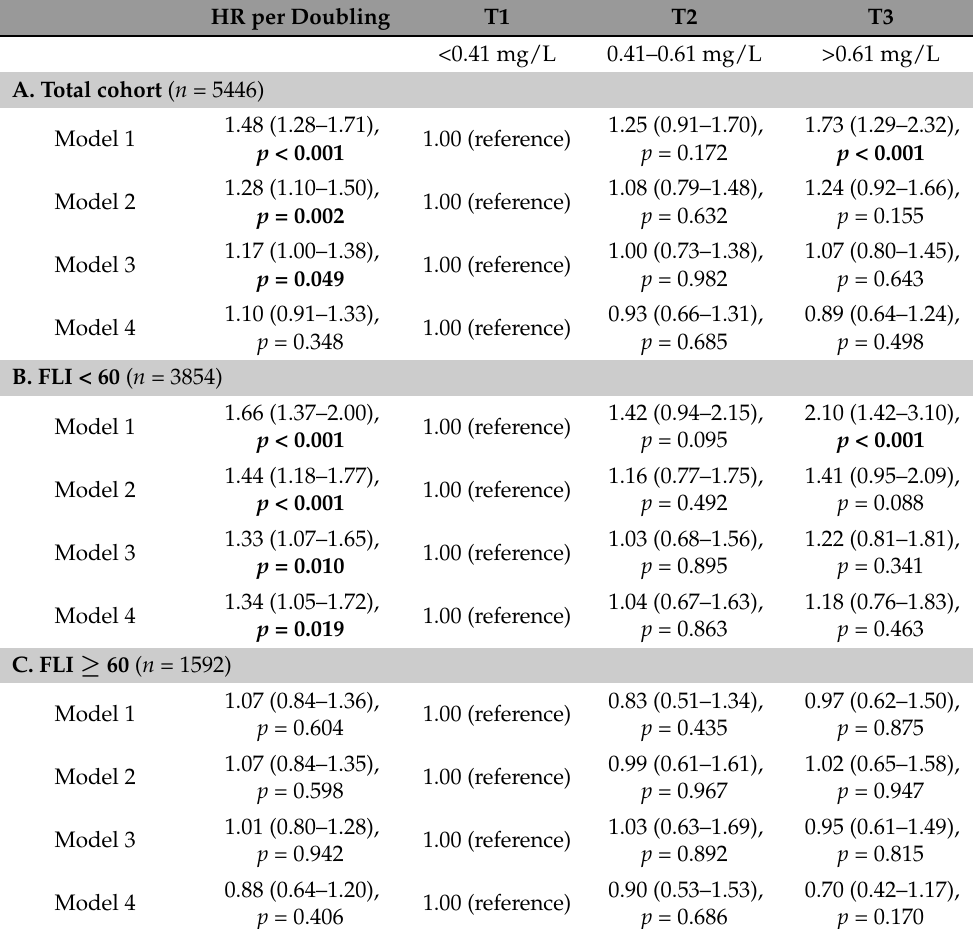
Table 3. Cox proportional hazards regression analyses for associations between plasma calprotectin levels and the risk of all-cause mortality in the total cohort (A) and separately in subjects with FLI < 60 (B) and FLI ≥ 60